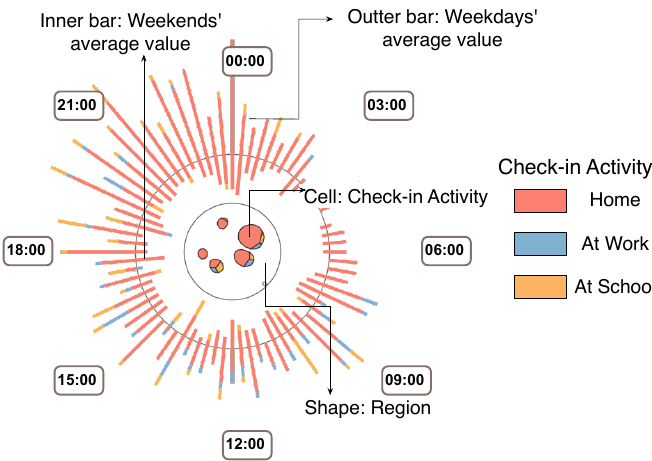
Figure 3. User-based Fingerprint on Social Check-in Behaviors. Inside this icon we use different geometric circles to encode the regions visited by this user group. The Voronoi cells inside the circles encode the type of check-in activity and the size of the Voronoi cell encodes the related number of check- ins of that activity in the region. The color is also used to categorize the activity type shown in the right part of the figure. The outer bar presents the average weekday value, while inner bar shows the average weekend value. Each bar is formed by a set of slices of different lengths. One slice on the bar represents one type of activity and its length shows the related number of